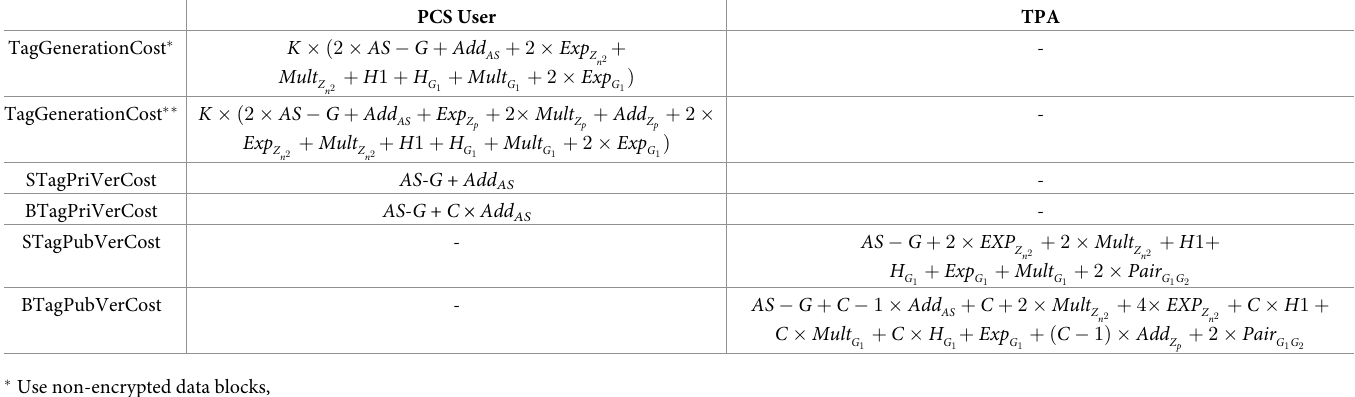
Table 8. Tag generation and verification